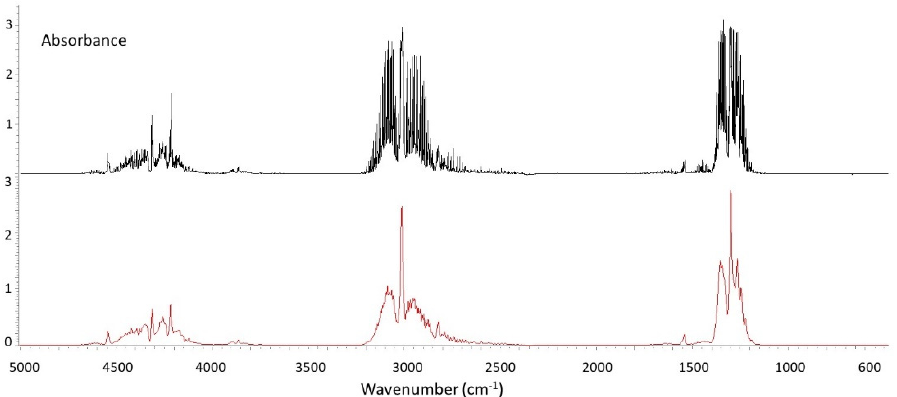
Figure 5. Effect of the nominal resolution on the IR natural gas spectra. Black: 1 cm − 1 ; Red: 8 cm − 1 resolution.